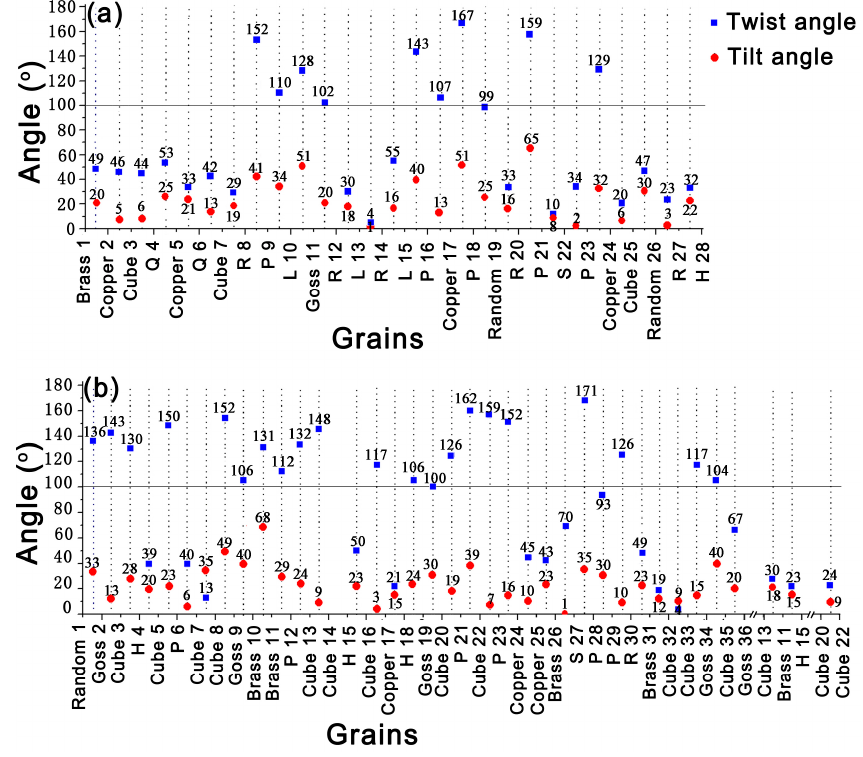
Figure 9. The twist angle and tilt angle between neighboring grains for samples A ( a ) and B ( b ) (Note: the perpendicular dotted line between the neighboring grains represents the grain boundary.).